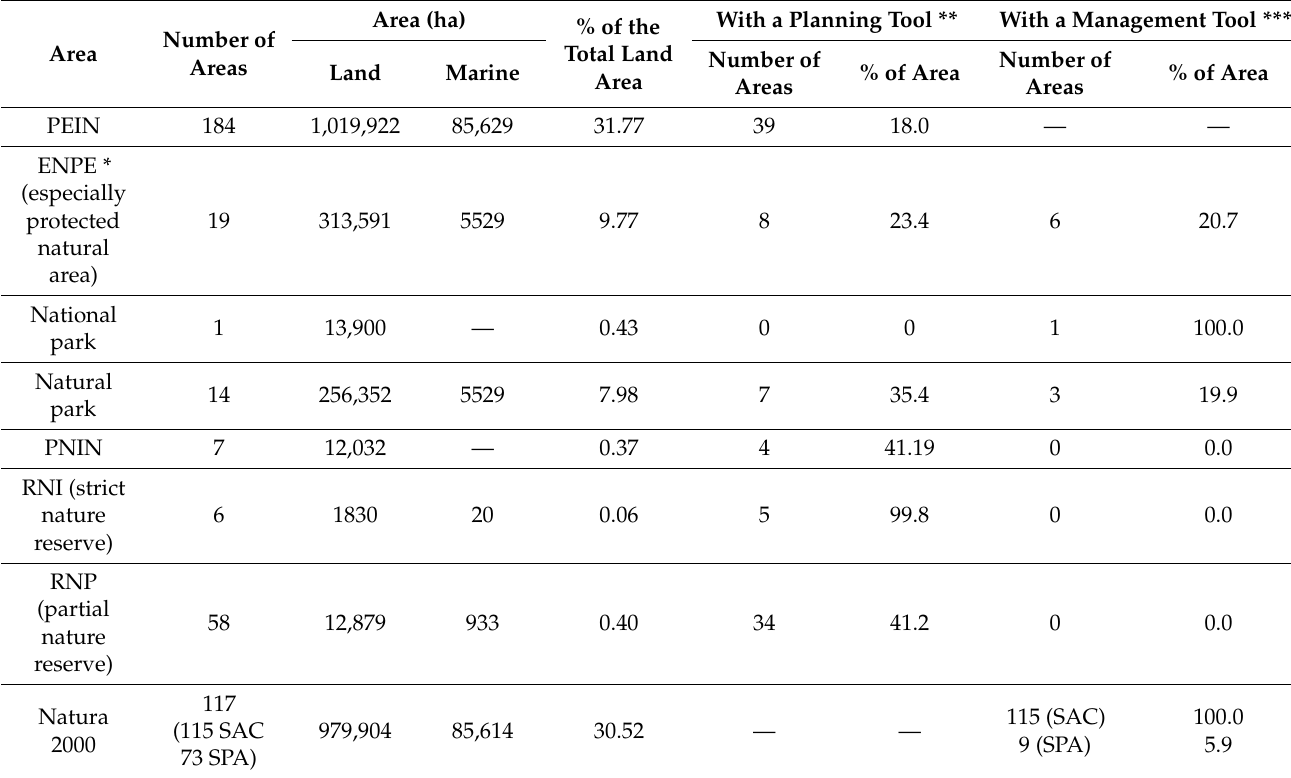
Table 18. Availability of planning and management tools in the system of protected natural areas in Catalonia. Source: Natural Environment Planning Service (situation as of the end of